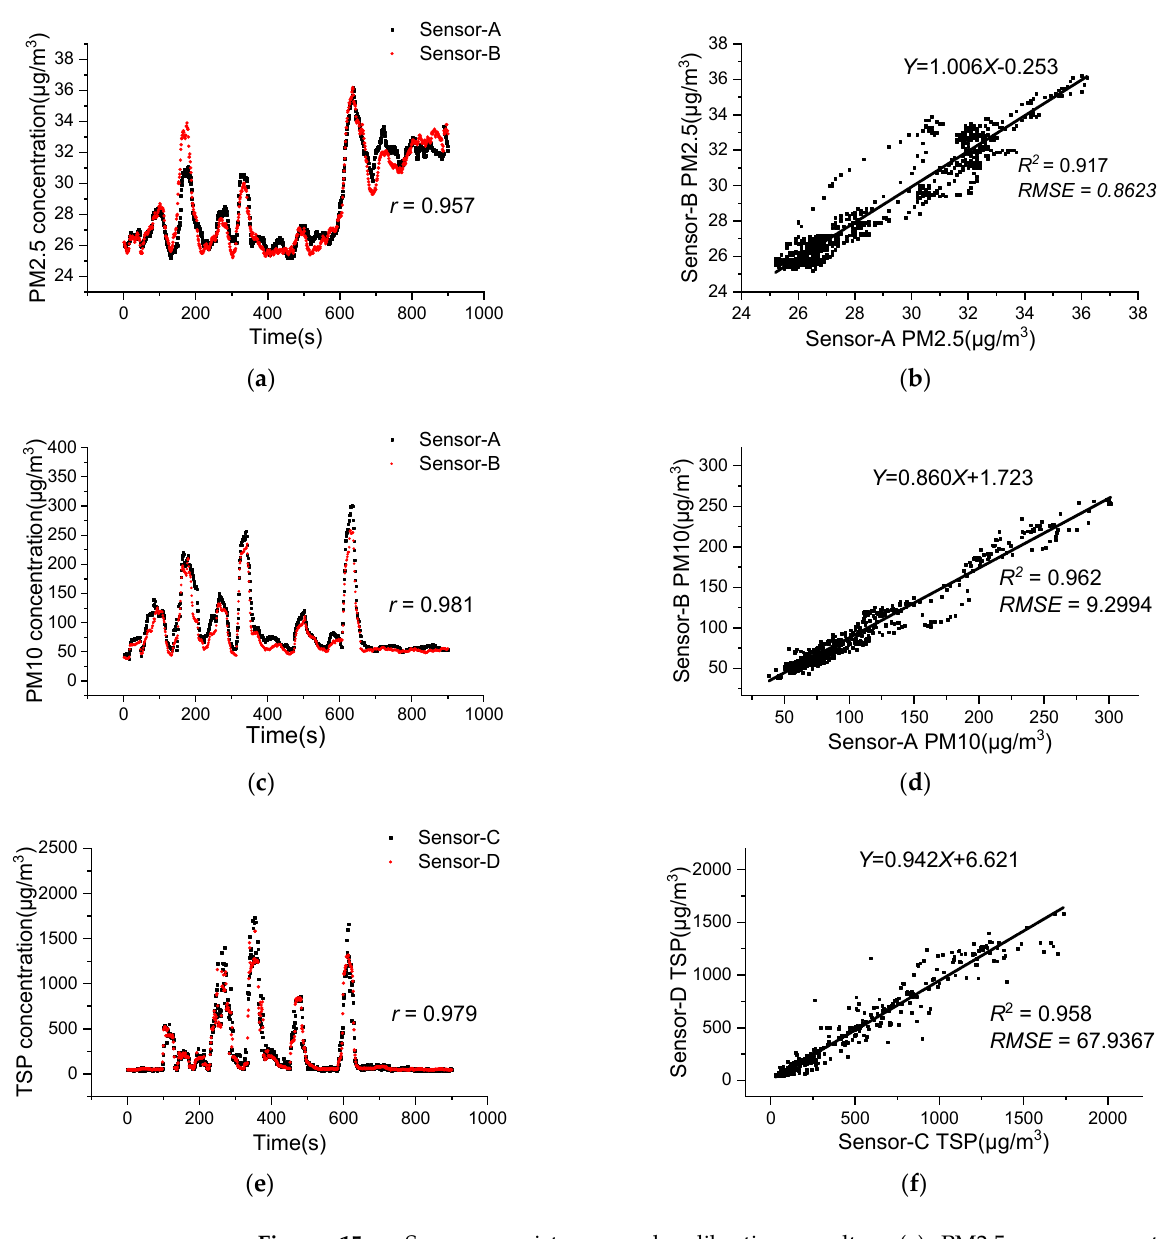
Figure 14. Agri-environmental measurement experimental site: ( a ) setting of measurement point; ( b ) the drone performing flight measurement work.